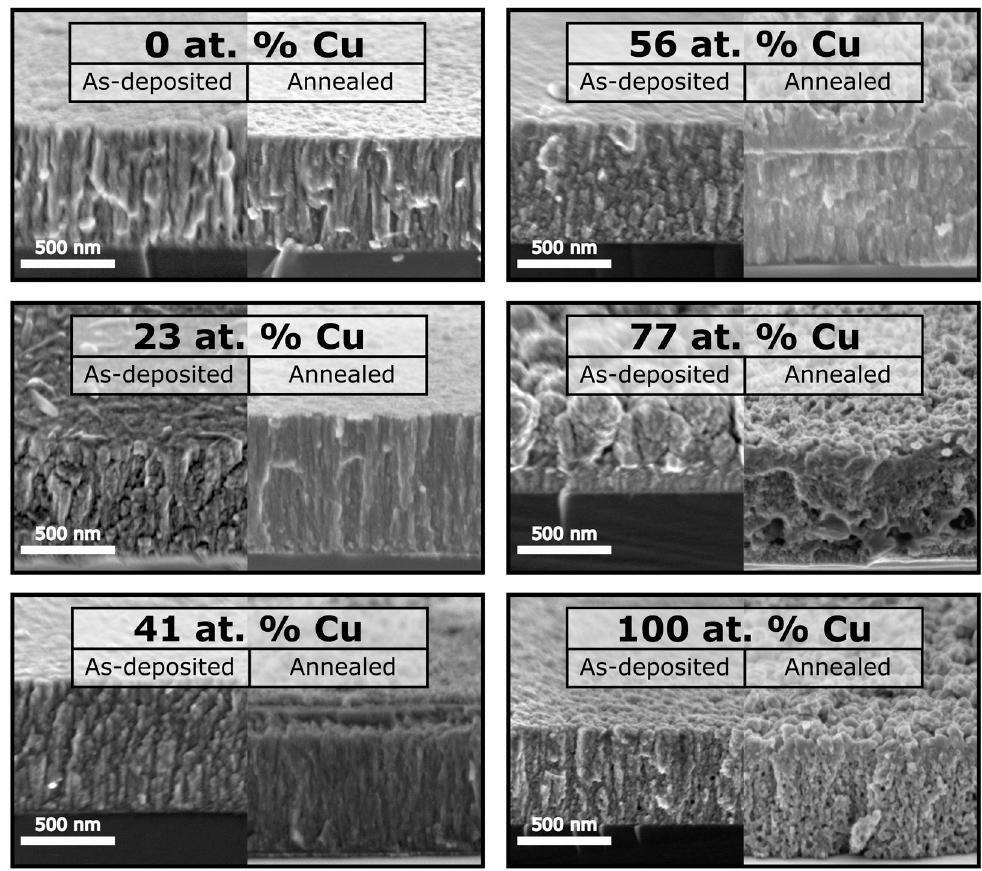
Figure 1. SEM cross-section images of as-deposited and annealed at 473 K TiO x , (CuTi)Ox, and Cu x O thin fi lms.